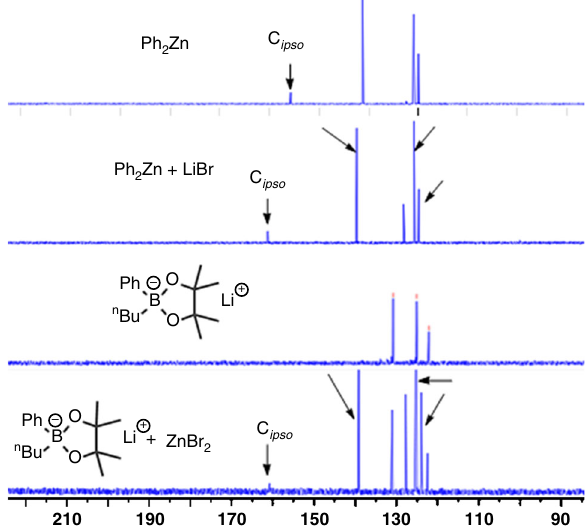
Fig. 4 NMR detection of intermediates. 13 C NMR spectra of Ph 2 Zn, Ph 2 Zn + LiBr, 2a and 2a + ZnBr 2 in